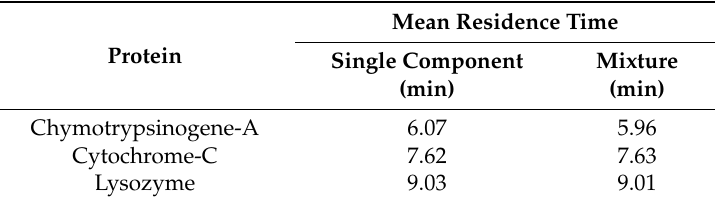
Table 2. Deviation from single component to mixture measurement.